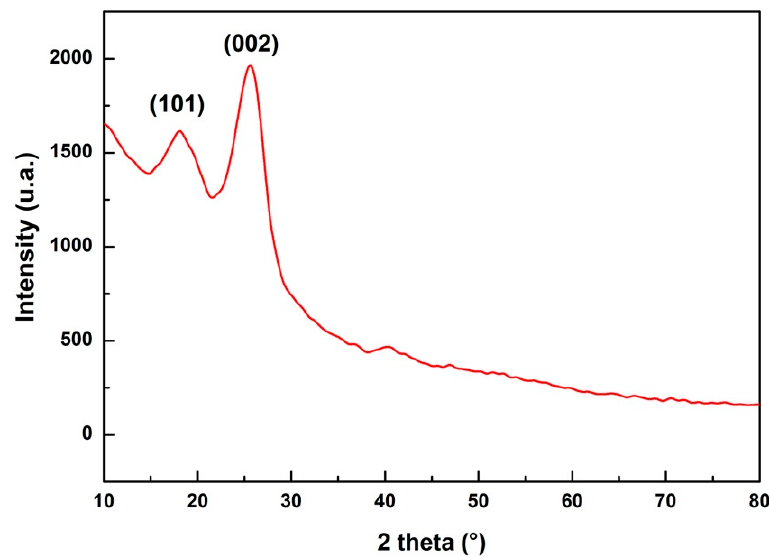
Figure 3. XRD diffractogram of sedge fiber.